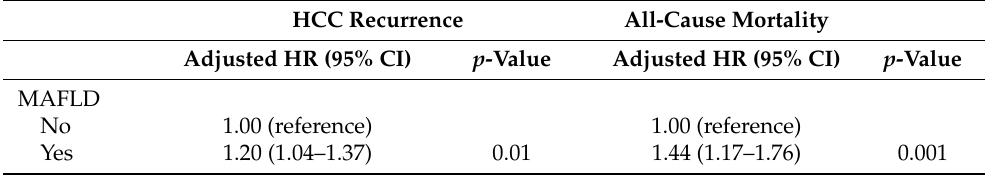
Figure 1. Cumulative incidence plots of postoperative HCC recurrence ( a ) and all-cause mortality ( b ) stratified by MAFLD among the entire cohort. Table 2. Adjusted HRs and 95% CIs of HCC recurrence and all-cause mortality by MAFLD in chronic HBV